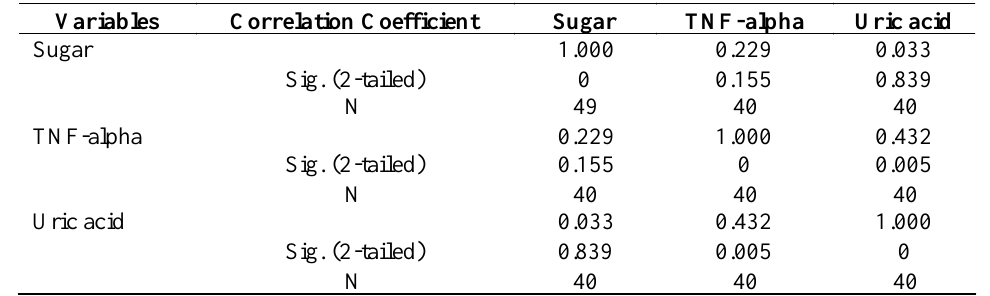
Table II : Spearman’s correlation among blood sugar, uric acid and TNF alpha Among cases and controls